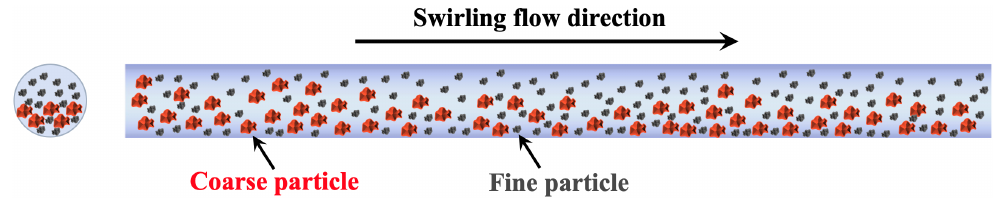
Figure 1. Schematic diagram of the three-phase deep ocean transportation